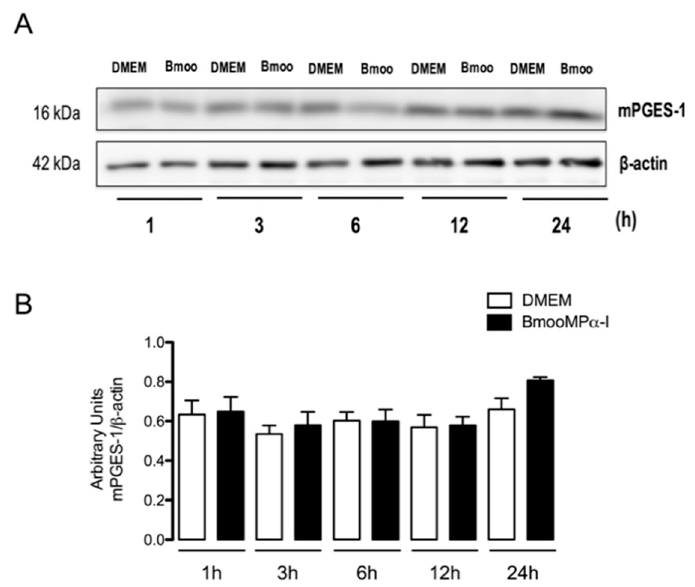
Figure 3. BmooMP α -I does not alter mPGES-1 protein expression in preadipocytes. Preadipocytes were incubated with BmooMP α -I (0.24 µ M) (Bmoo) or DMEM (control) for 1, 3, 6, 12, and 24 h: ( A ) representative Western blotting of mPGES-1 and β -actin (loading control) showing immunoreactive bands; ( B ) densitometric analysis of immunoreactive mPGES-1 bands. Densities (in arbitrary units) were normalized to β -actin densities. Results are expressed as means ± SEM of 4 samples.